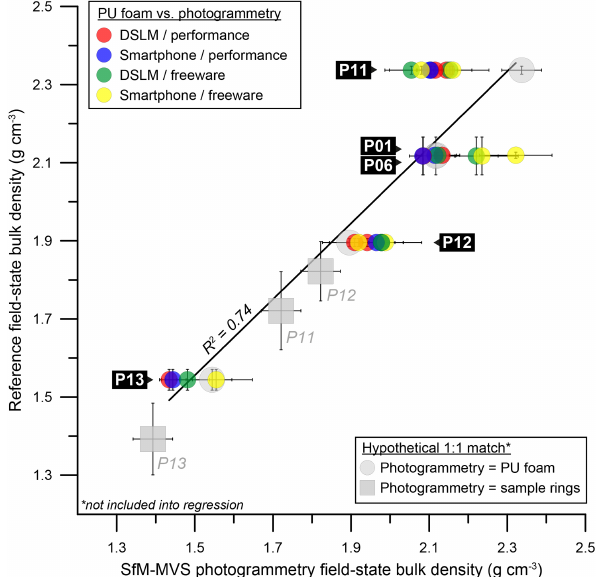
Figure 8. Pit (BD17-P01 to BD17-P12) and cavity (BD17- P13) densities derived using PU foam/polystyrene casts (refer- ence densities) and the photogrammetry workflows presented in this study. Hypothetically matching values obtained from the PU foam/polystyrene casts and soil sample rings are indicated by large grey circles and squares (errors on the ordinate reflect measure- ment standard deviations; errors on the abscissa reflect the standard deviation of all photogrammetry-based densities for the respective sites). For discussion, see